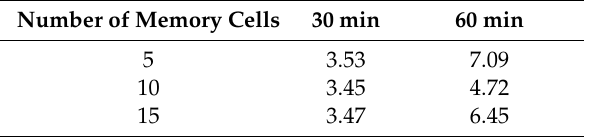
Table 1. Root Mean Square Error (RMSE) values in mg / dL. In total, 70% training 30% validation.